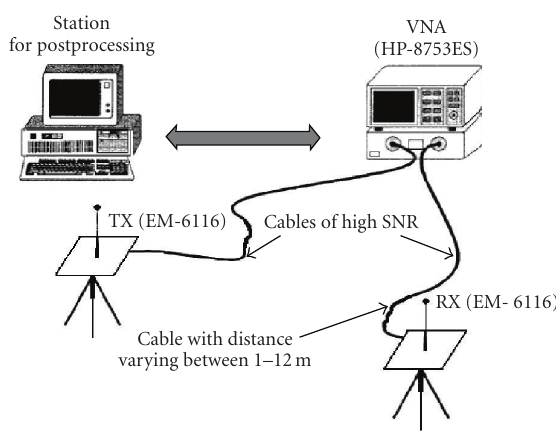
Figure 1: Channel measurement setup.